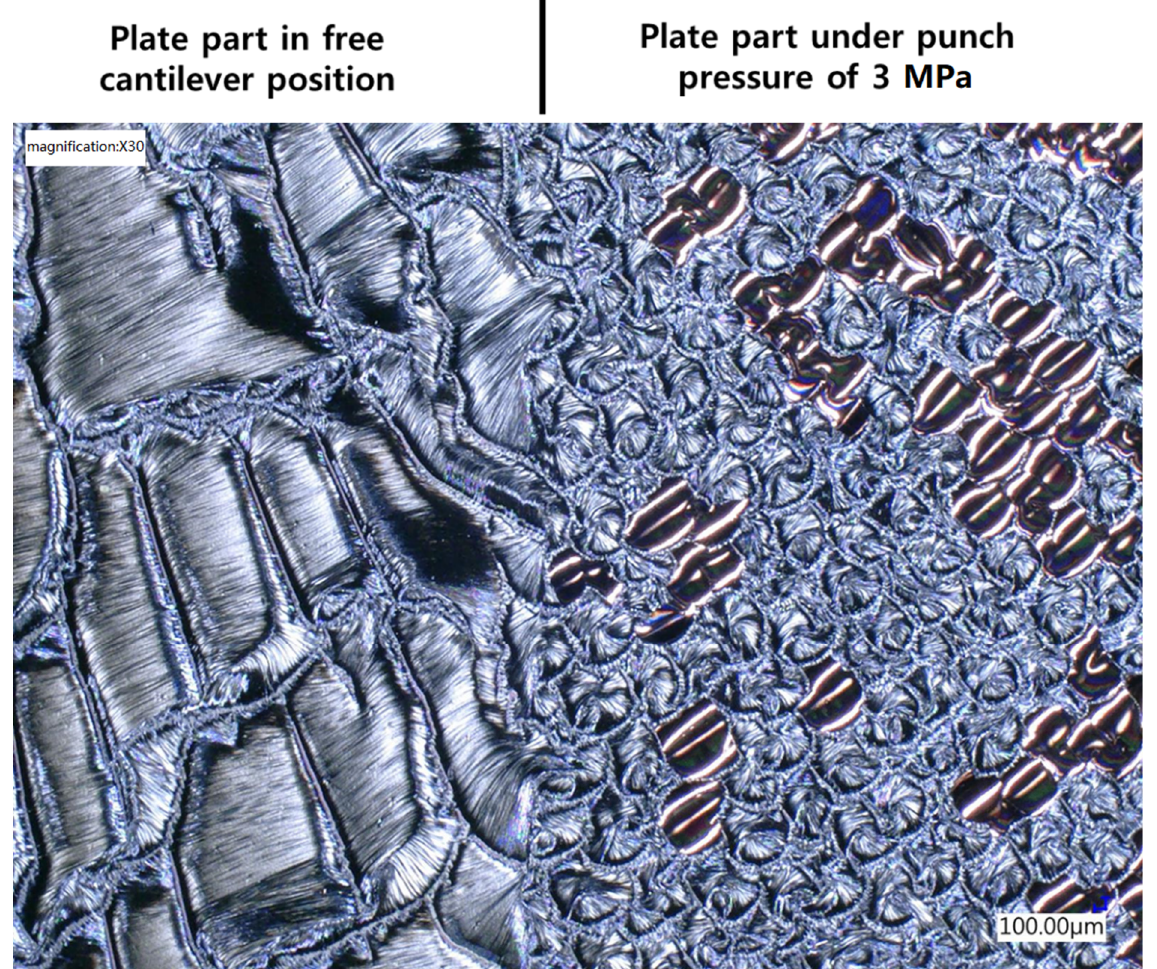
Figure 21. Optical microscope image showing the effect of the ignition under pressure on the reaction product microstructure configuration for Pd/Al-Ni/Al